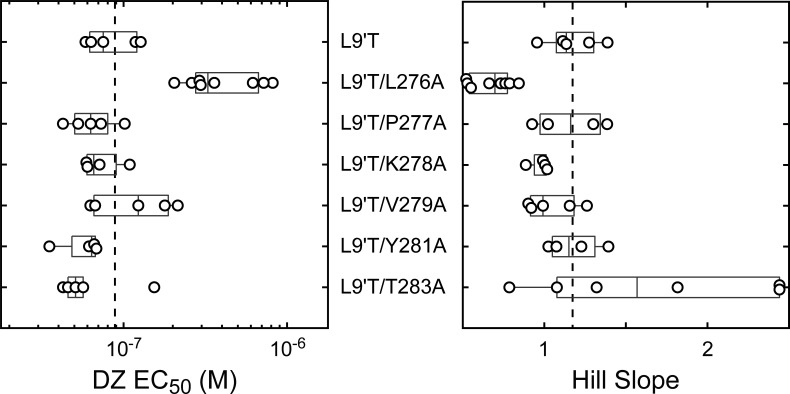
Summary of DZ EC50 and hill slope from fitting Equation 1 to DZ concentration–response relationships as shown in Figure 4 for individual oocytes.Gray box plots indicate the median and 25th and 75th percentiles. The vertical dashed line is the mean for L9'T.